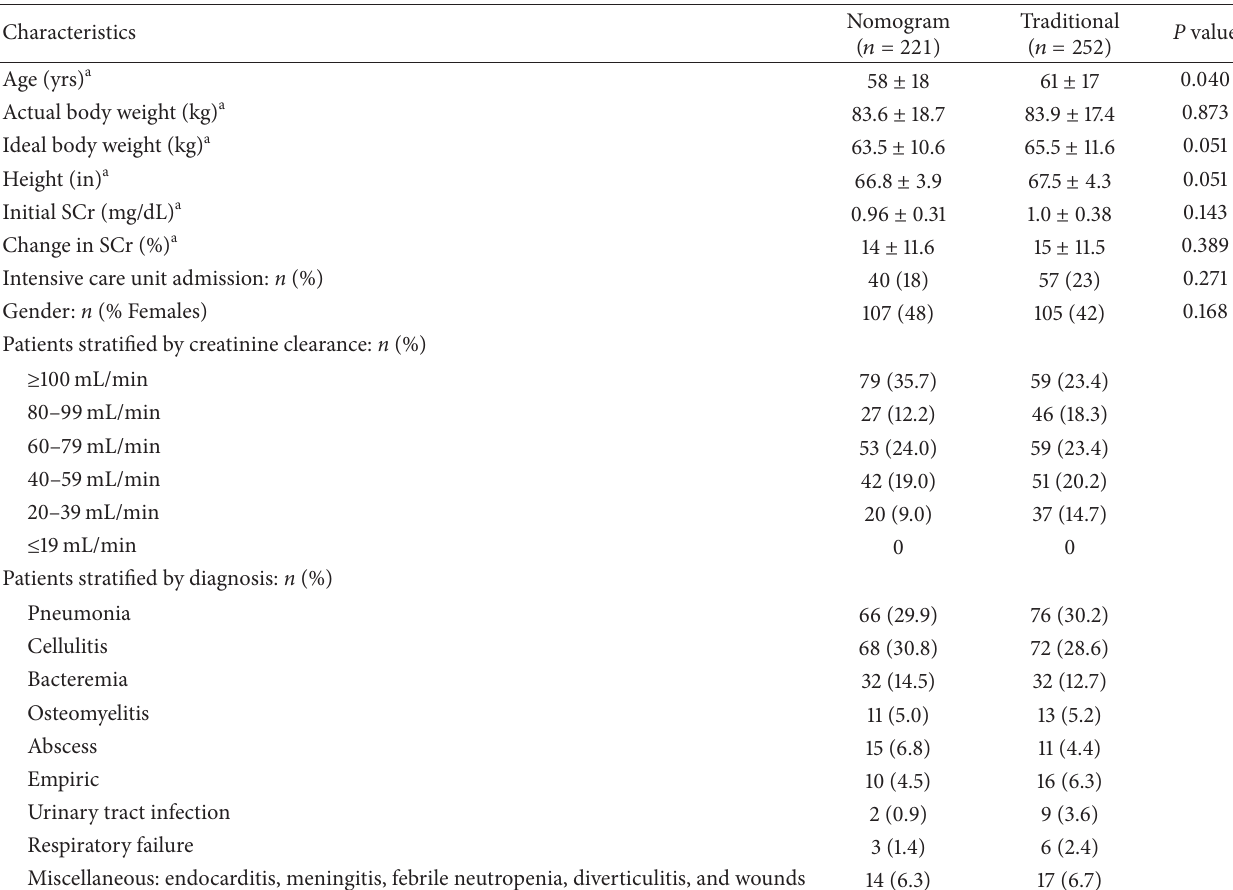
Table 1: Characteristics of study